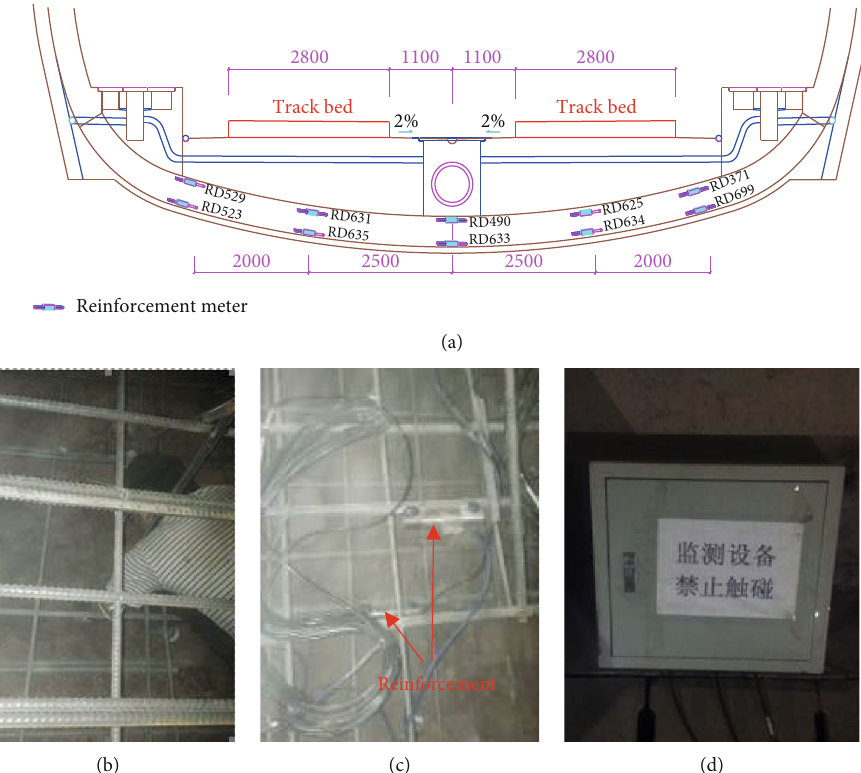
Figure 2: Field test characteristics: (a) locations of reinforcement meters (cm), (b) installation of extensometers, (c) installed extensometers, and (d) equipment box at the